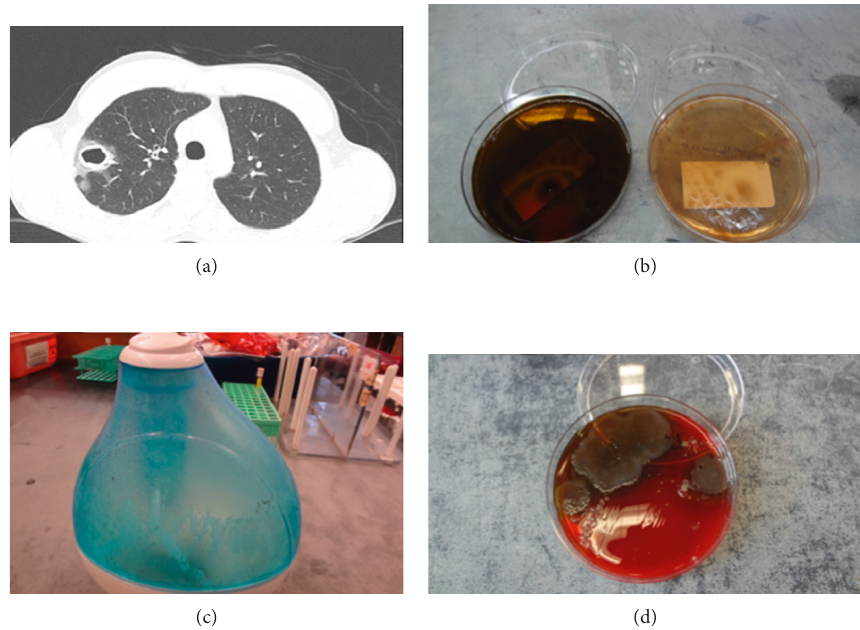
Figure 1: (a) Cross section of CT chest showing a right upper lobe cavitary lesion. (b) Respiratory cultures plated on blood and soy agar. (c) Humidifier with film inside water basin. (d) Humidifier culture on blood agar showing colony growth with